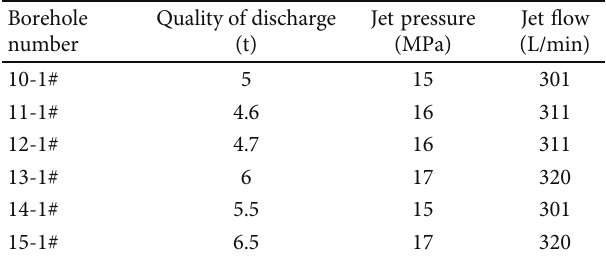
Figure 14: Gas extraction in the borehole group 9#. Table 3: Test parameters in the fi rst punching